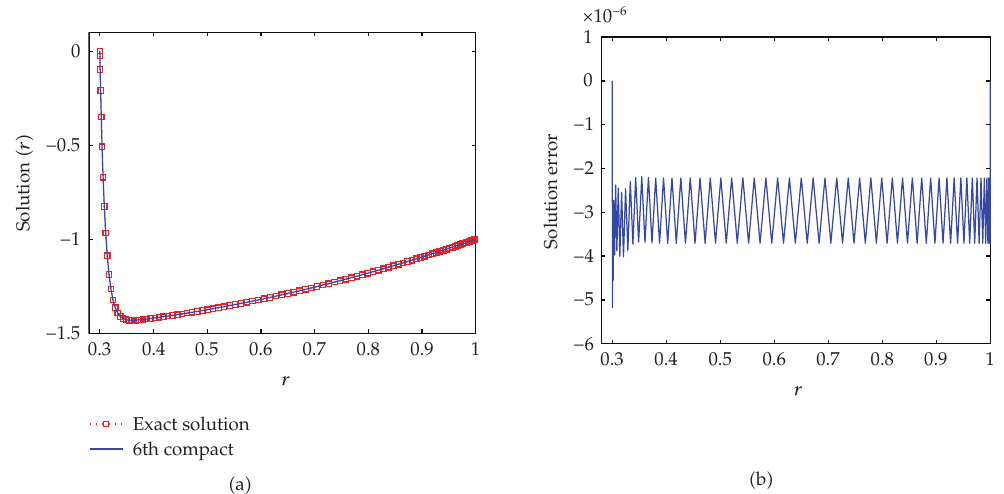
Figure 4: (cid:6) a (cid:7) Solutions of the benchmark problem 2. (cid:6) b (cid:7) The solution error of the sixth-order compact scheme. The resolution was set at N (cid:9) 100 and the parameter was (cid:5) (cid:9) 0 . 01.